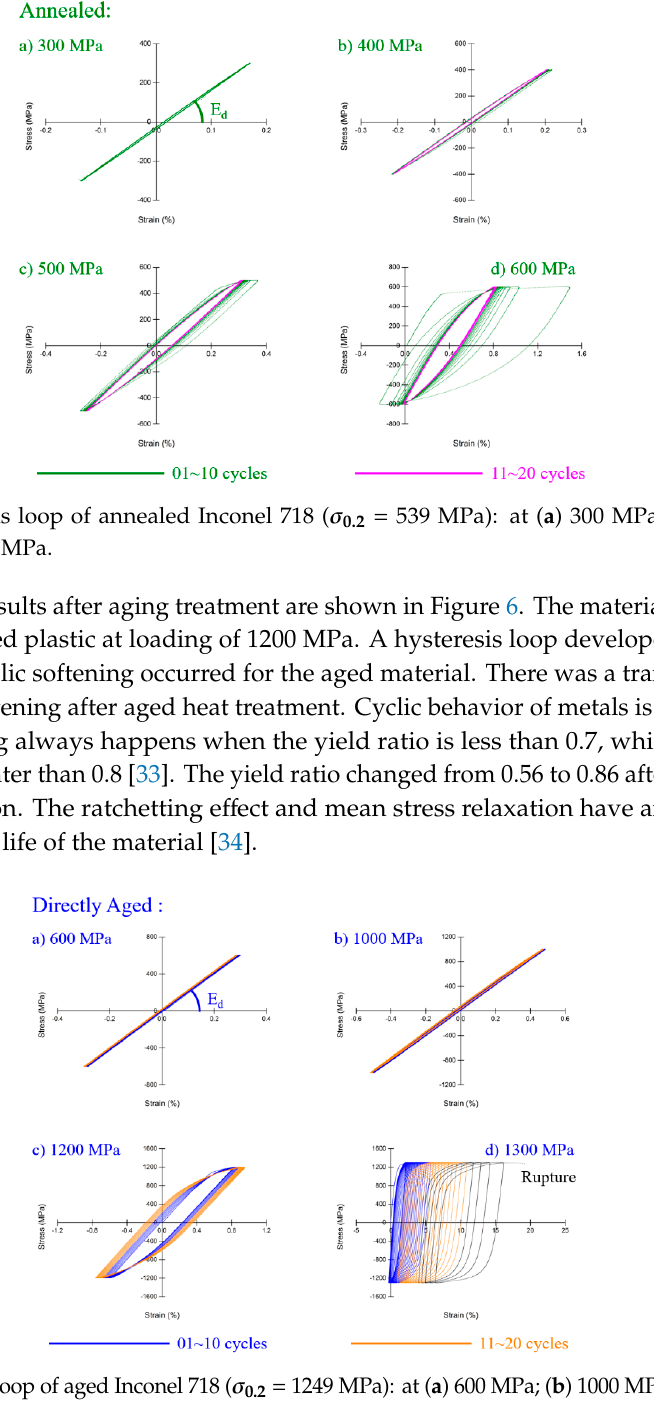
Table 5. Dynamic modulus under different loading frequencies. Elastic Modulus (GPa)